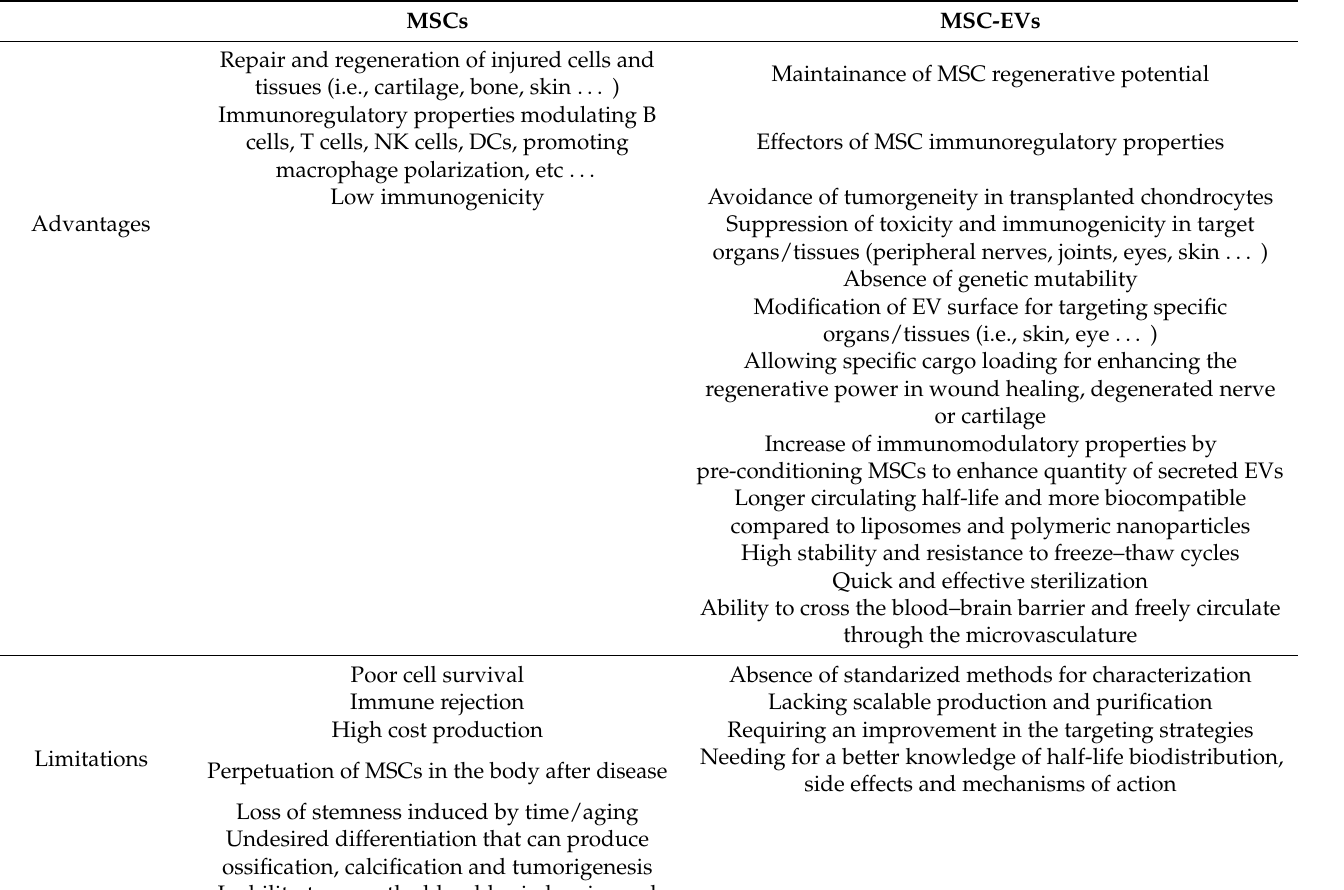
Table 2. Advantages and limitations of MSC and MSC-EVs for therapy in autoimmune diseases. MSCs